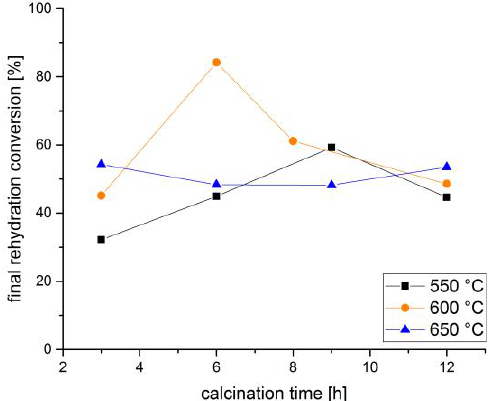
Figure 3. Final conversion for rehydration of the various MgCO 3 -originating MgO samples CO 3 -4 in the P-XRD.